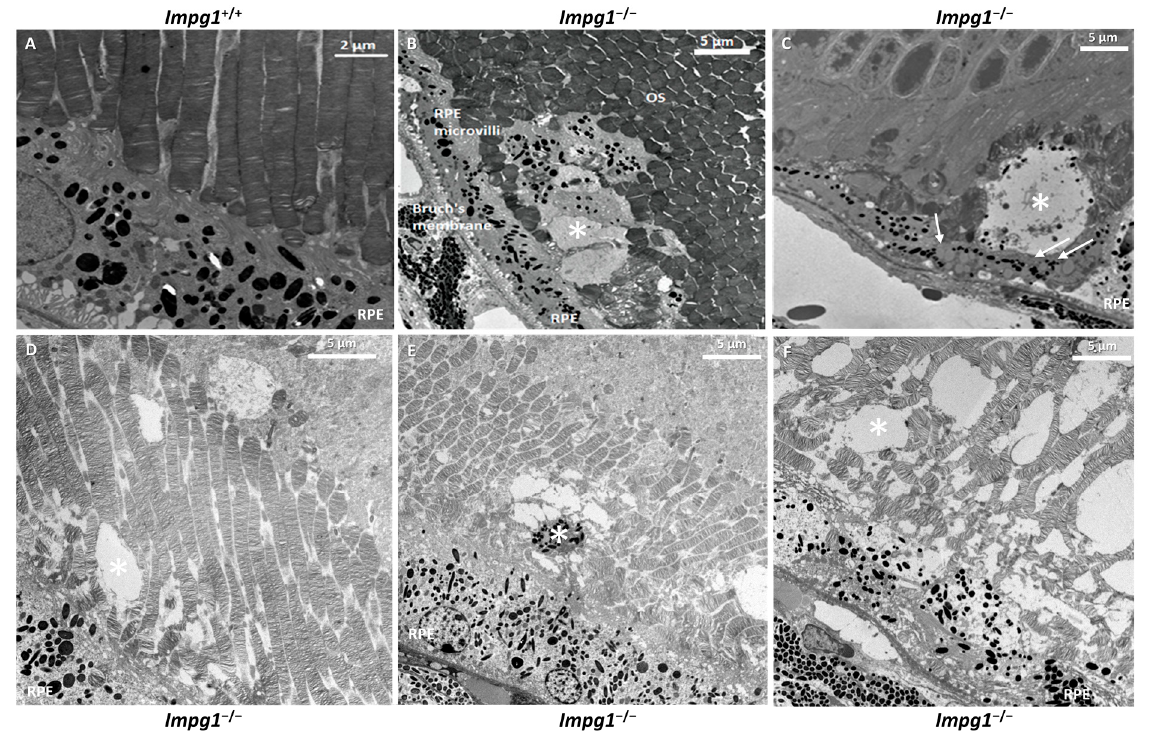
Figure 6. Abnormal accumulation of cellular material in the IPM. Transmission electron microscopy (TEM) on the retinas of 14-month-old wild-type Impg1 +/+ control ( A ) and Impg1 − / − ( B – F ) mice. In the absence of SPACR protein, internal buildup of vacuole-like structures at the photoreceptor-RPE interface was observed (asterisk). In addition, an accumulation of lipid droplets can be seen in the RPE cells (arrows) in contact with this material.